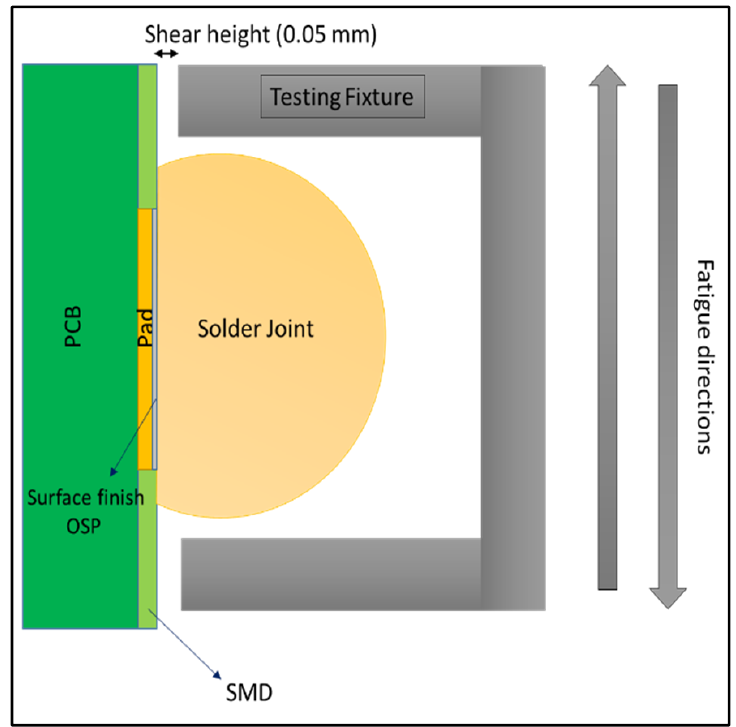
Figure 3. Testing fixture.